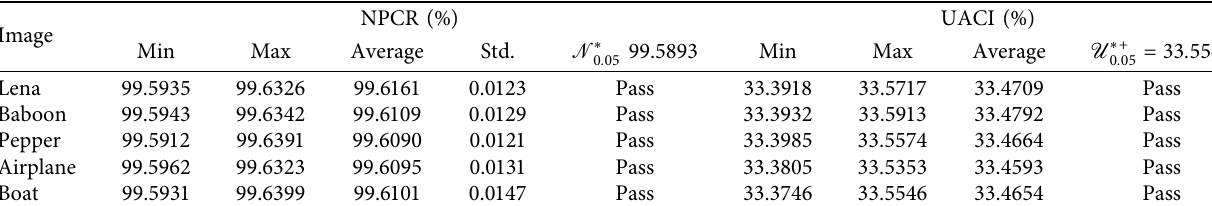
Table 1: The results of NPCR and UACI.